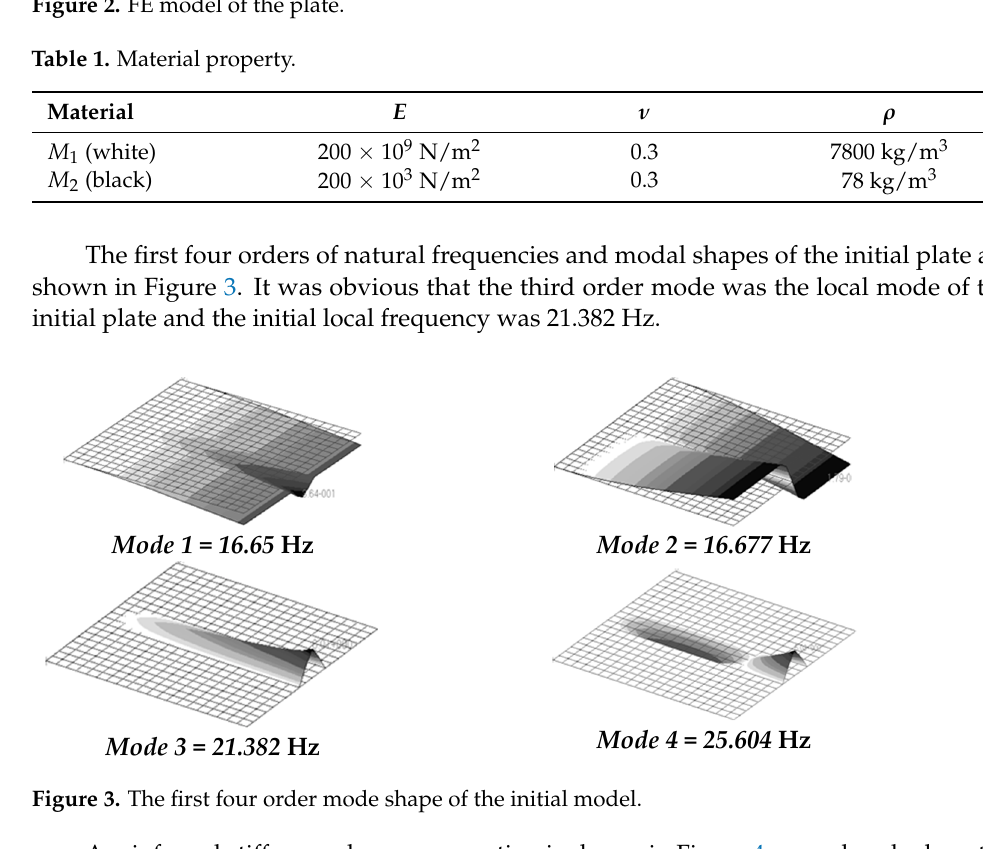
Figure 4. FE model of the stiffened plate. Performing a modal analysis and the first four orders of the natural frequencies and modal shapes of the plate with the reinforced stiffener is shown in Figure 5. The natural frequencies changed slightly and the third order mode was also the local mode. In this way, modifying the design of the cross section to satisfying the local frequency constraint with the minimum mass increasement was the optimization problem.